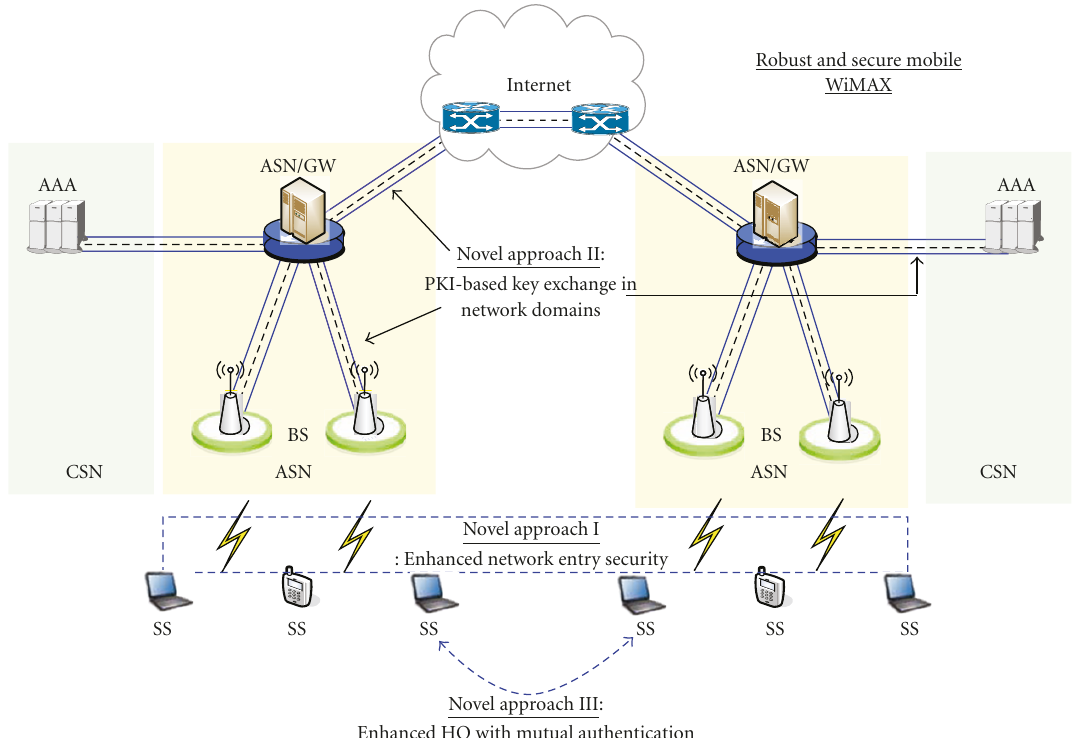
Figure 7: Robust and secure mobile WiMAX